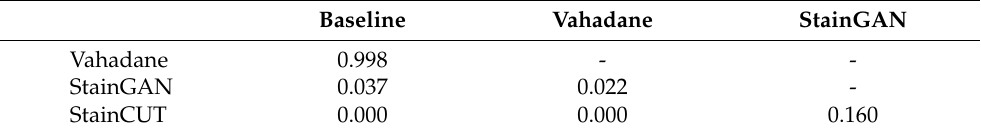
Table A8. p -values obtained from the Nemenyi test applied to the RUMC with Setting (1).